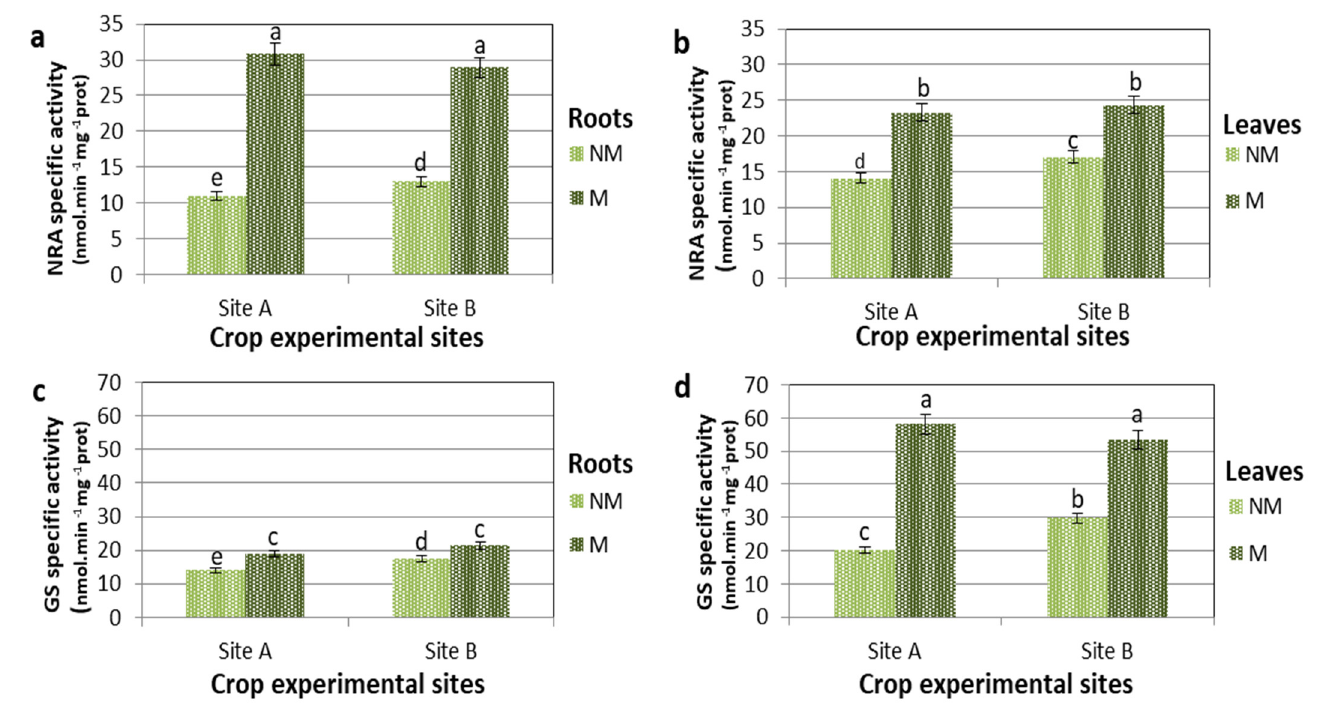
Figure 2. Nitrate reductase (NRA) and Glutamine synthetase (GS)specific activities of control (NM) and M plants of Triticum durum grown in two different soil sites (A and B) and collected at 190 DAS. Data are for NRA in roots ( a ) and in leaves ( b ), and GS in roots ( c ) and leaves ( d ). Specific activities are expressed in nmol min − 1 mg − 1 protein. The values are means ± SD of ten biological replicates ( n = 10). Values marked by common letters are not statistically different at p ≤ 5% according to Tukey’s test.